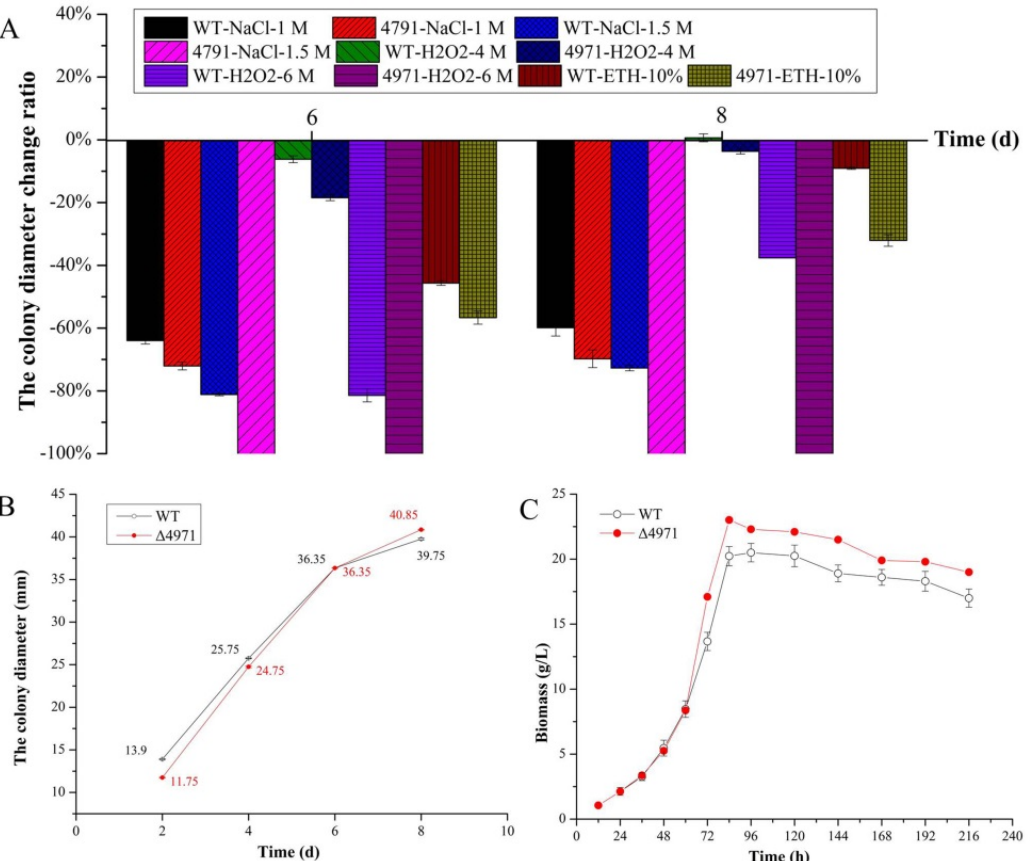
Figure 5. The change ratio of colony diameters of WT and ∆ 4971 strains on PDA medium with compounds supplementation ( A ), the colony diameters of them cultivated on PDA medium ( B ), the biomass of them during submerged batch-fermentation ( C ).